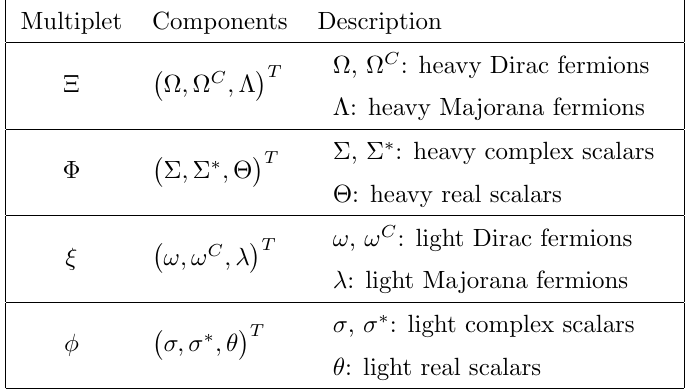
Table 1 . Contents of the di(cid:11)erent multiplets appearing in the